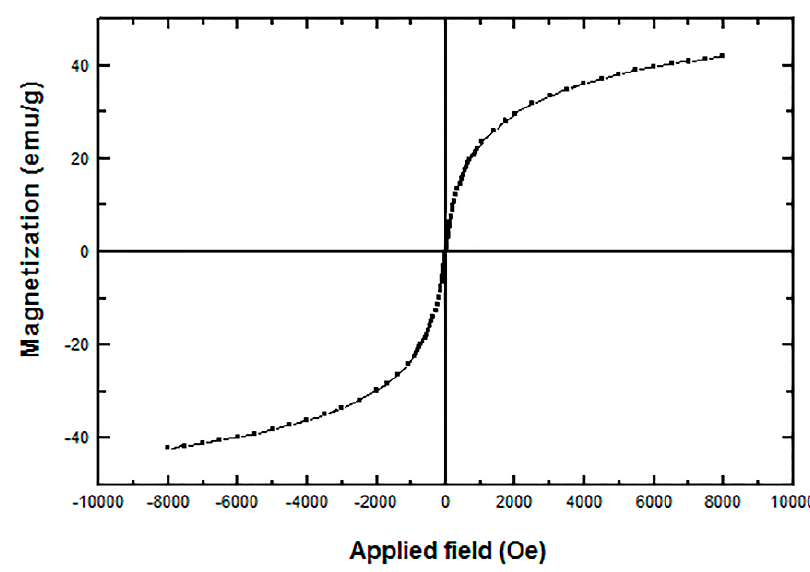
Figure 4. Vibrating sample magnetometer (VSM) diagrams of L -lysine coated magnetite nanoparticles.